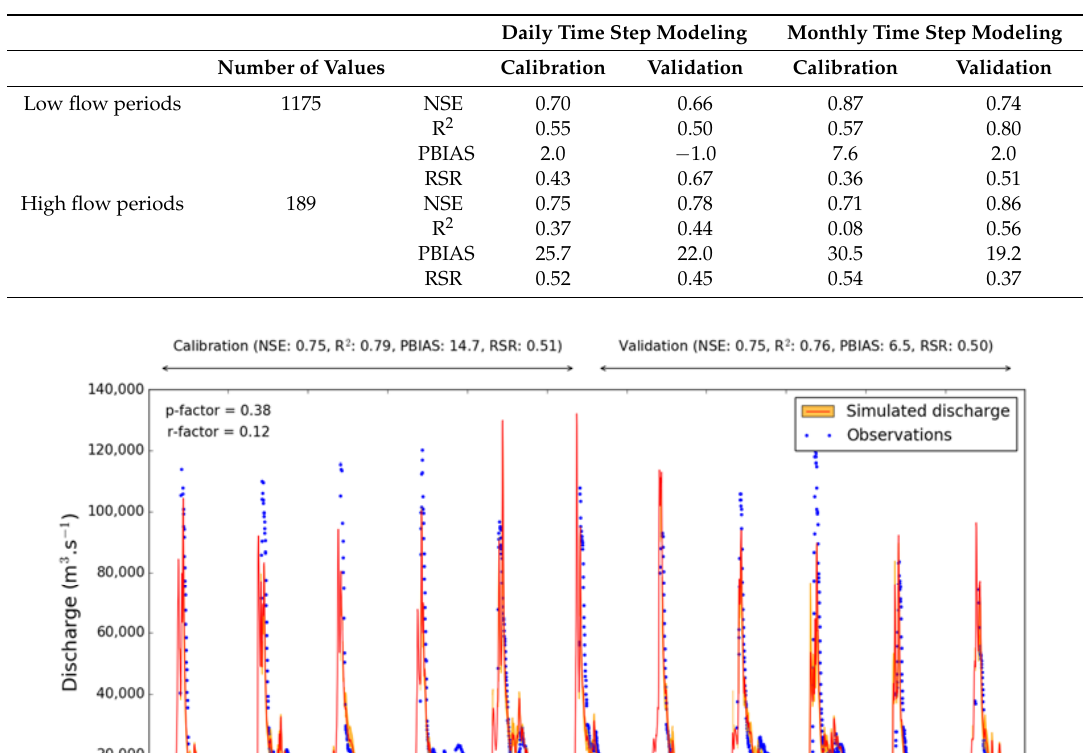
Table 1. Goodness of indices discretized by flow periods. Here, the discharge is considered high when it exceeds 30,000 m 3 s − 1 .